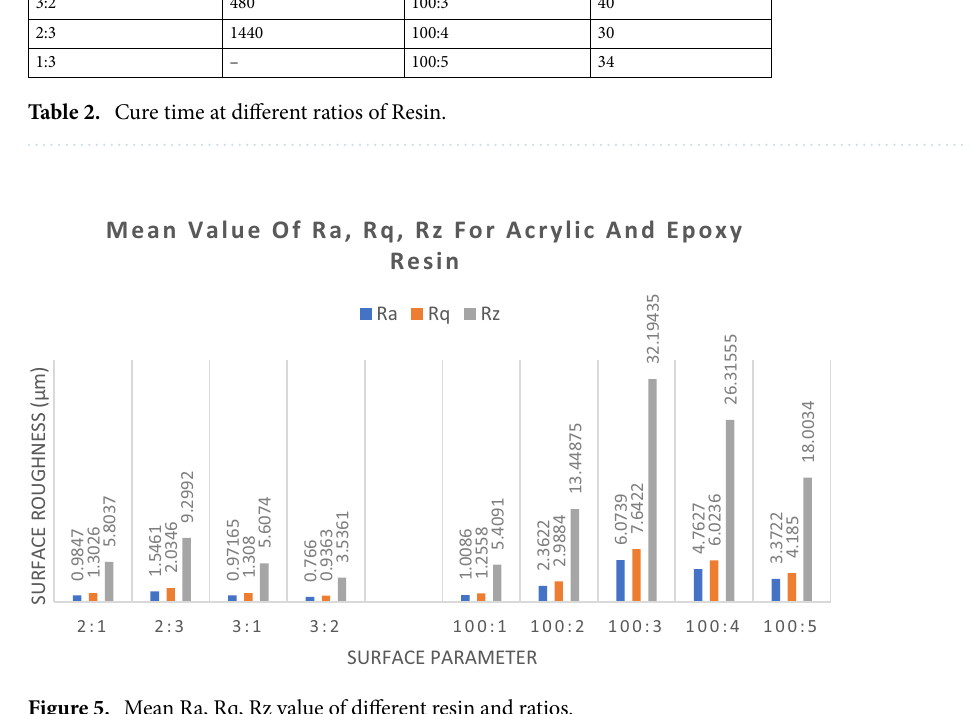
Figure 5. Mean Ra, Rq, Rz value of different resin and